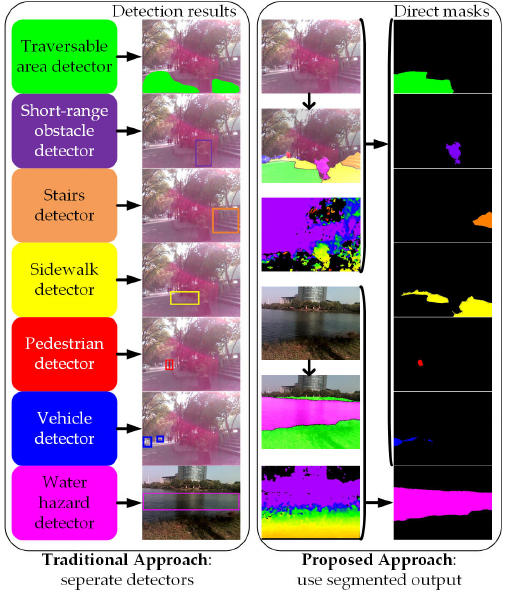
Figure 1. Two approaches of perception in navigational assistance for the visually impaired. A different example image is used for water hazards’ detection, but these images are all captured in real-world scenarios and segmented with the proposed